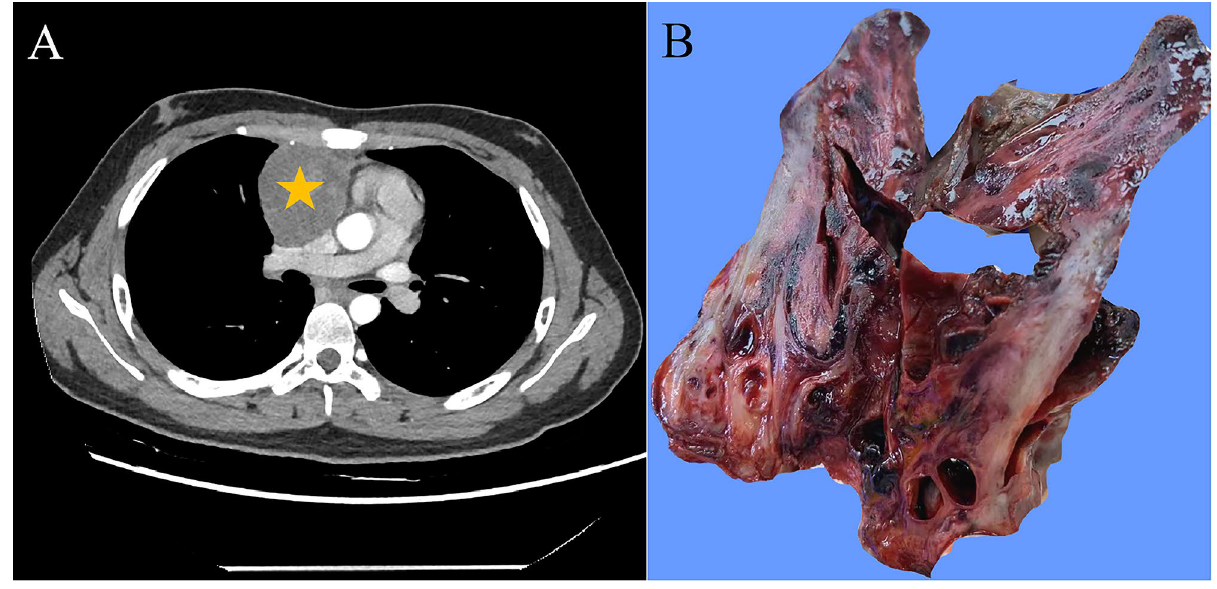
Fig. 1 Imaging and gross examination of the mediastinal tumour. (A) CT demonstrates a solid mass (yellow star) in the right anterior mediastinum with uneven density and well-defined boundaries. (B) The cut surface of the tumour was greyish ‒ white solid mixed with haemorrhagic cystic